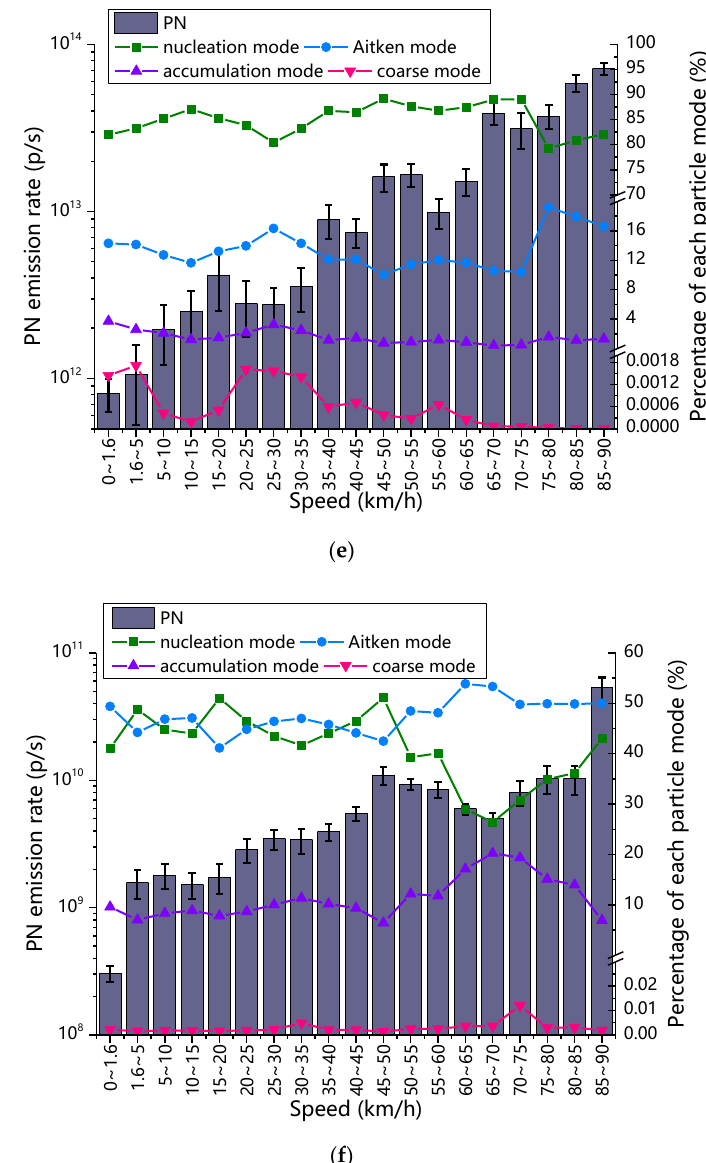
Figure 10. The relationship between speed, PN emission rates (average ± 95% confidence interval), and each particle mode of each test vehicle. ( a ) No. 4 (diesel truck, China IV); ( b ) No. 5 (diesel middle bus, China III); ( c ) No. 6 (diesel middle bus, China IV); ( d ) No. 7 (diesel bus, China III); ( e ) No. 8 (diesel bus, China IV); ( f ) No. 9 (LNG bus, China IV).